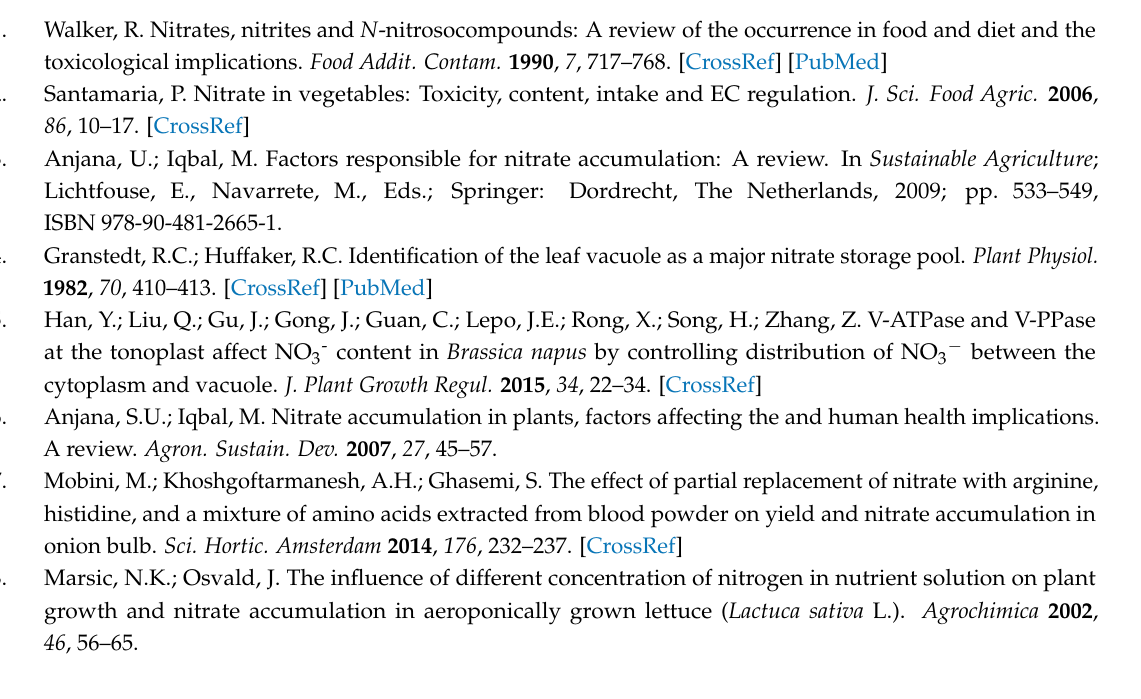
Supplementary Materials: The following are available online. Table S1: The relative expression levels of nitrate accumulation related genes under 0.5 and 15 mmol · L − 1 nitrate treatment conditions; Figure S1: The ratios of the relative gene expression under high to low nitrate